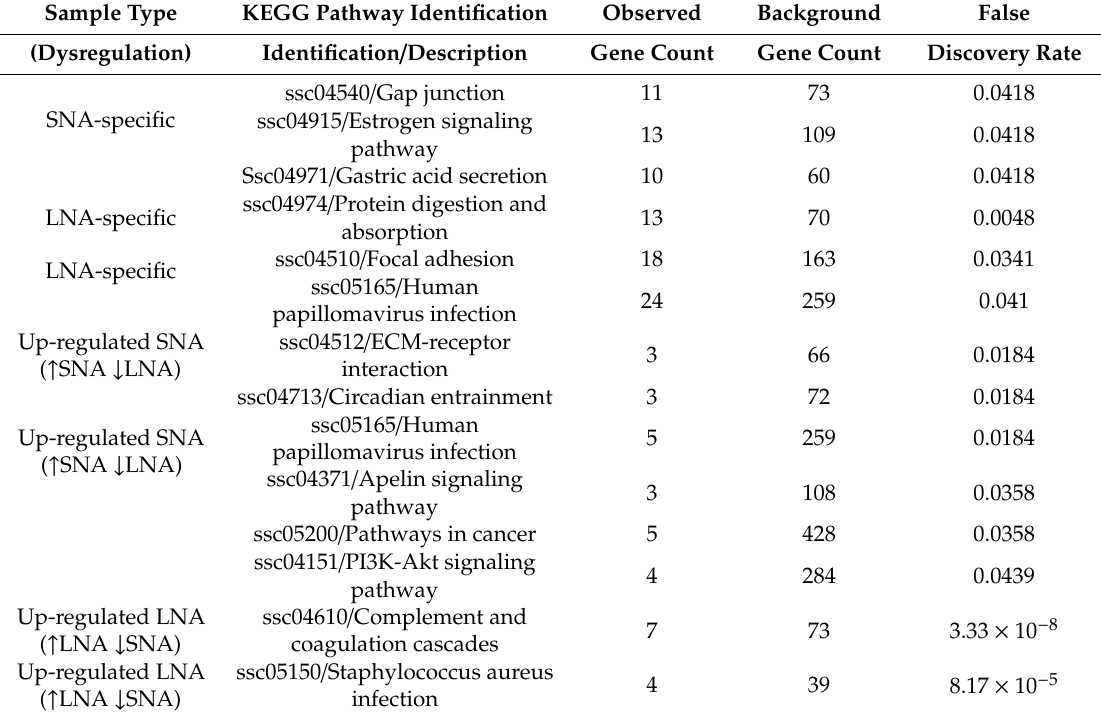
Table 3. Top enriched Kyoto Encyclopedia of Genes and Genomes (KEGG) pathways in up-regulated and specific proteins in SNA and LNA